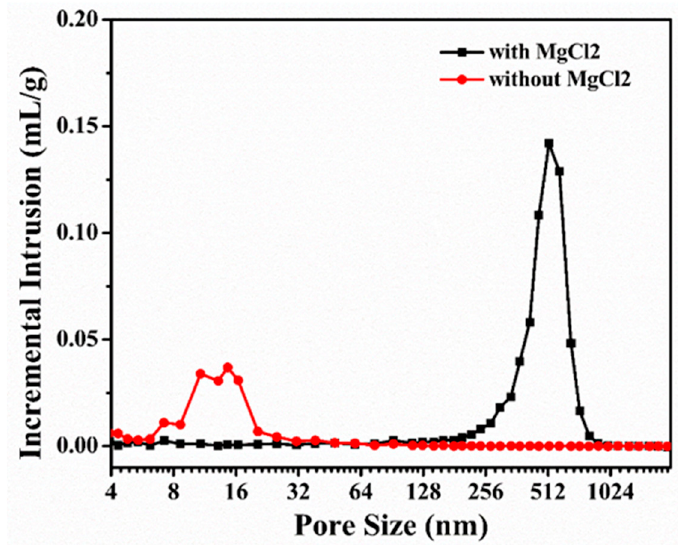
Figure 3. Pore size distributions deduced from mercury porosimetry.